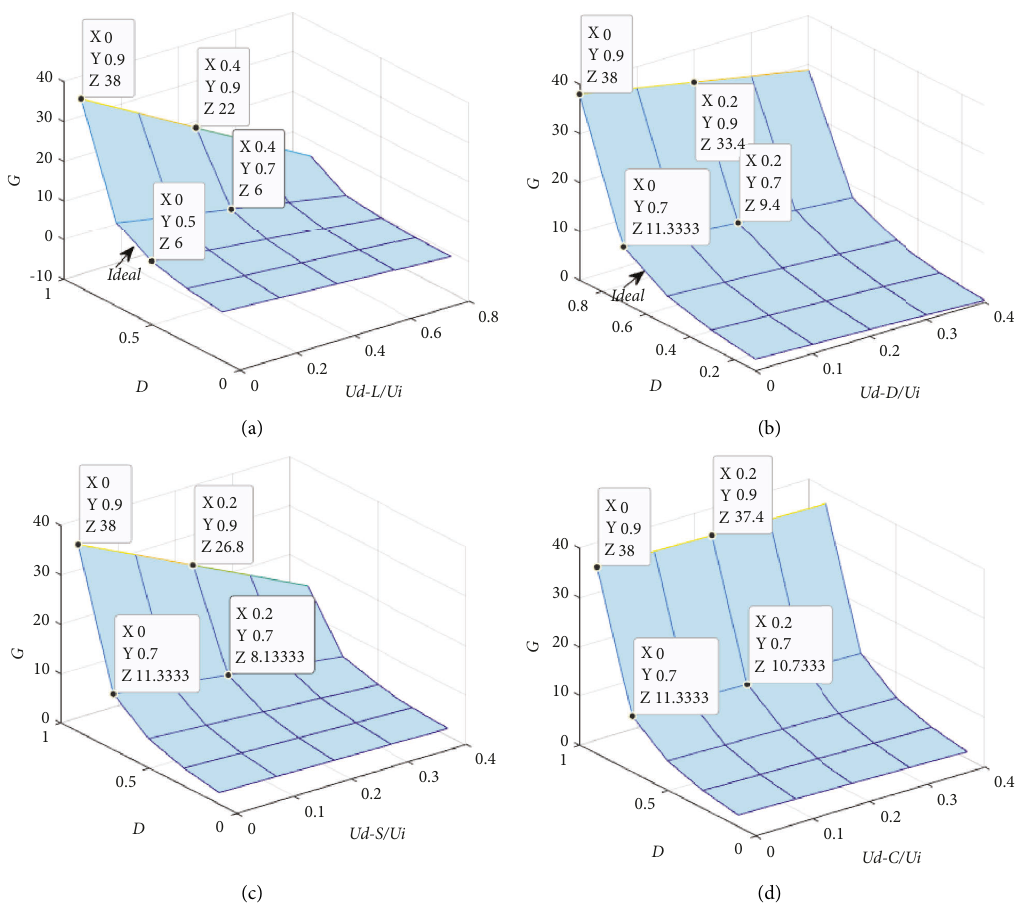
Figure 6: Nonideal effect on the duty cycle and voltage gain. (a) Inductors, (b) diodes, (c) switches, and (d)